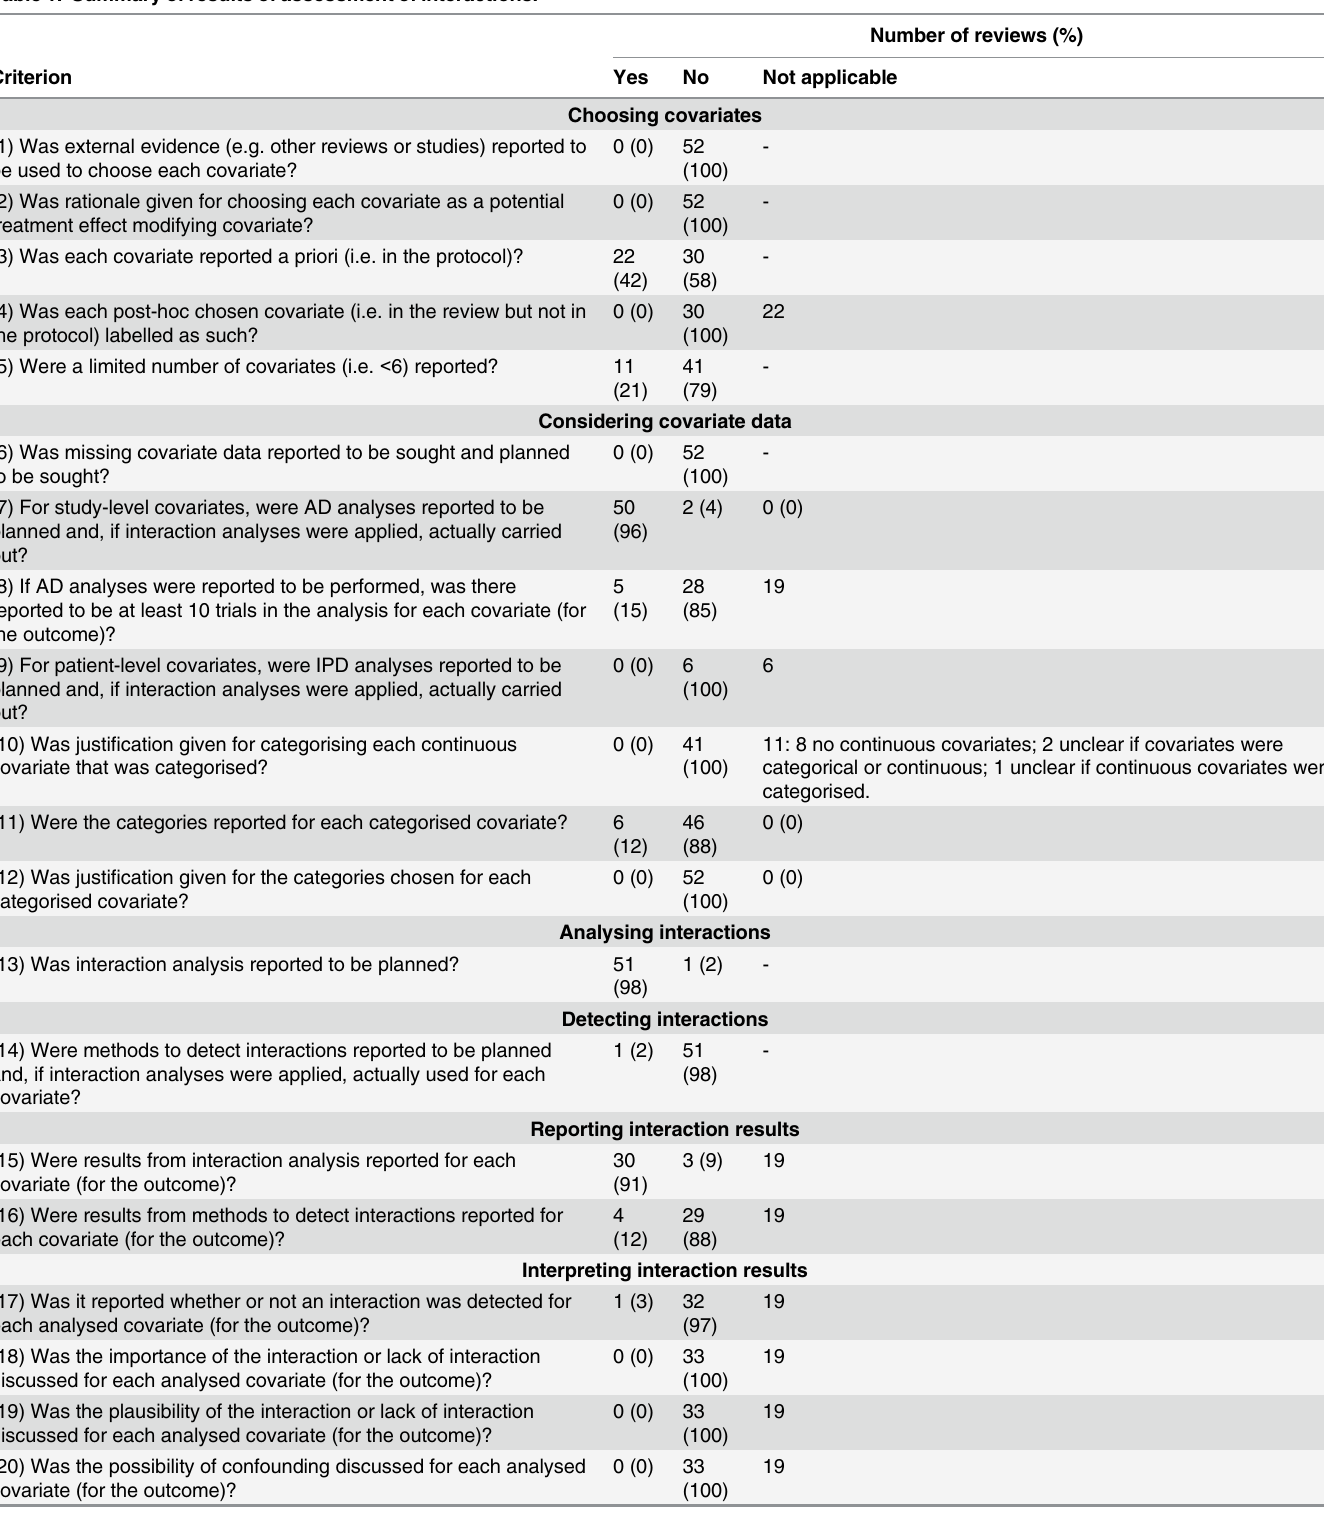
Table 1. Summary of results of assessment of